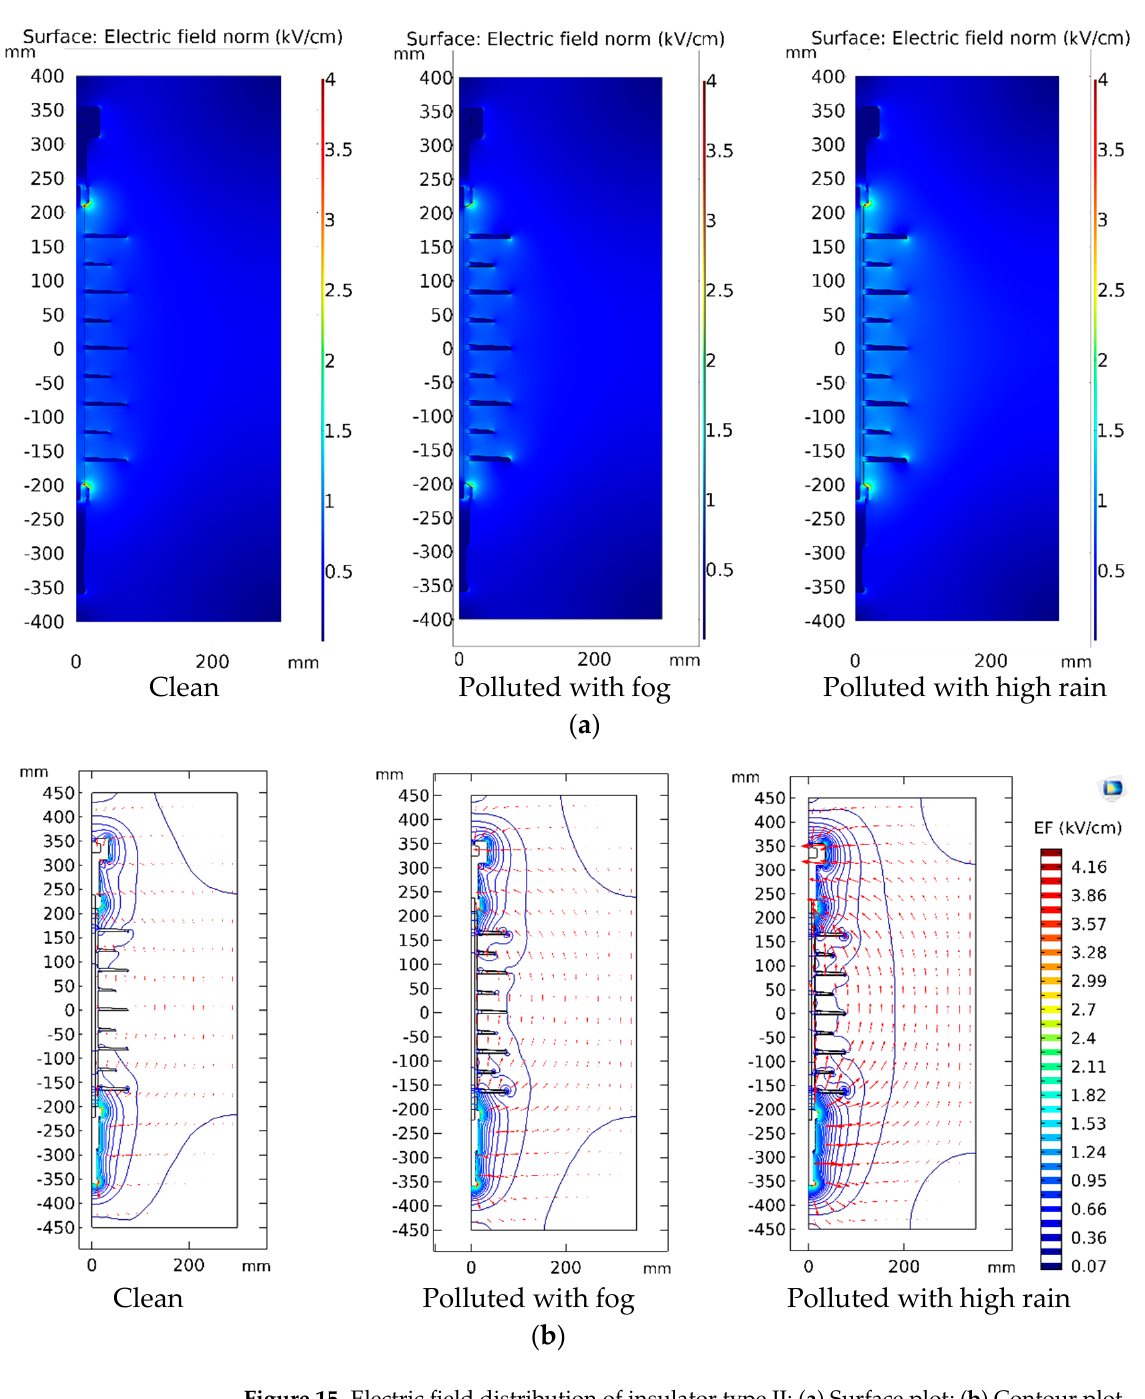
Figure 15. Electric field distribution of insulator type II: ( a ) Surface plot; ( b ) Contour plot.